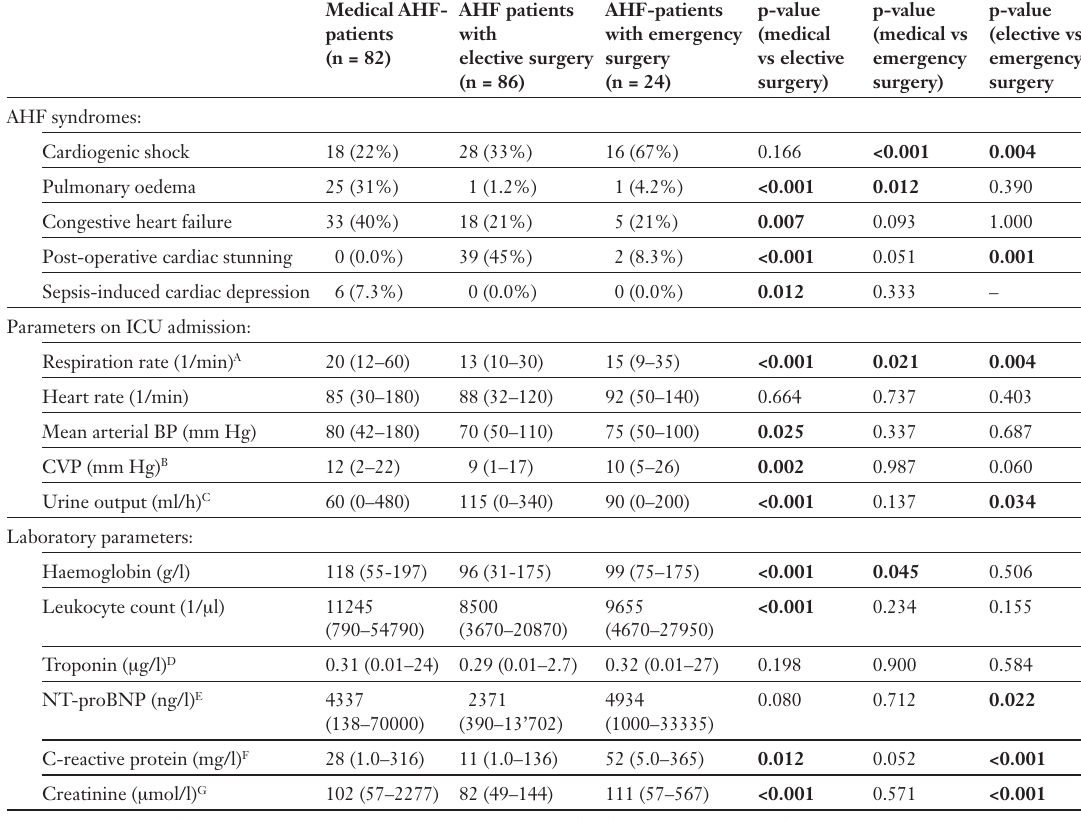
F 176 and G 185 patients.